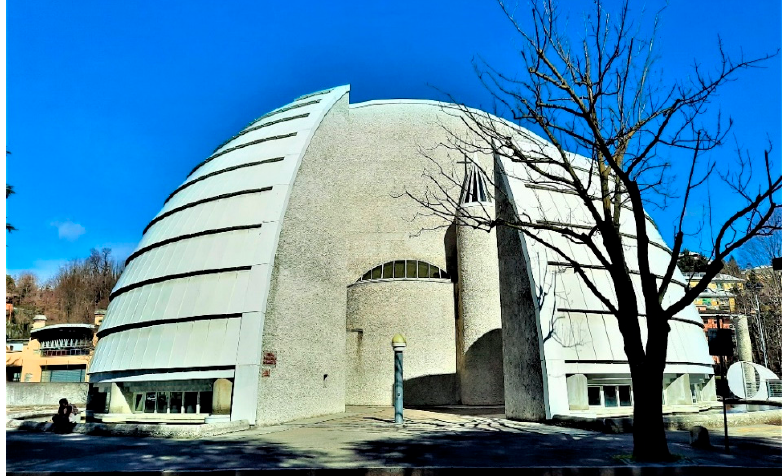
Figure 3. The southwest front of St. Maximilian Kolbe church, facing the avenue. Note the inner churchyard and the moat running around its base.